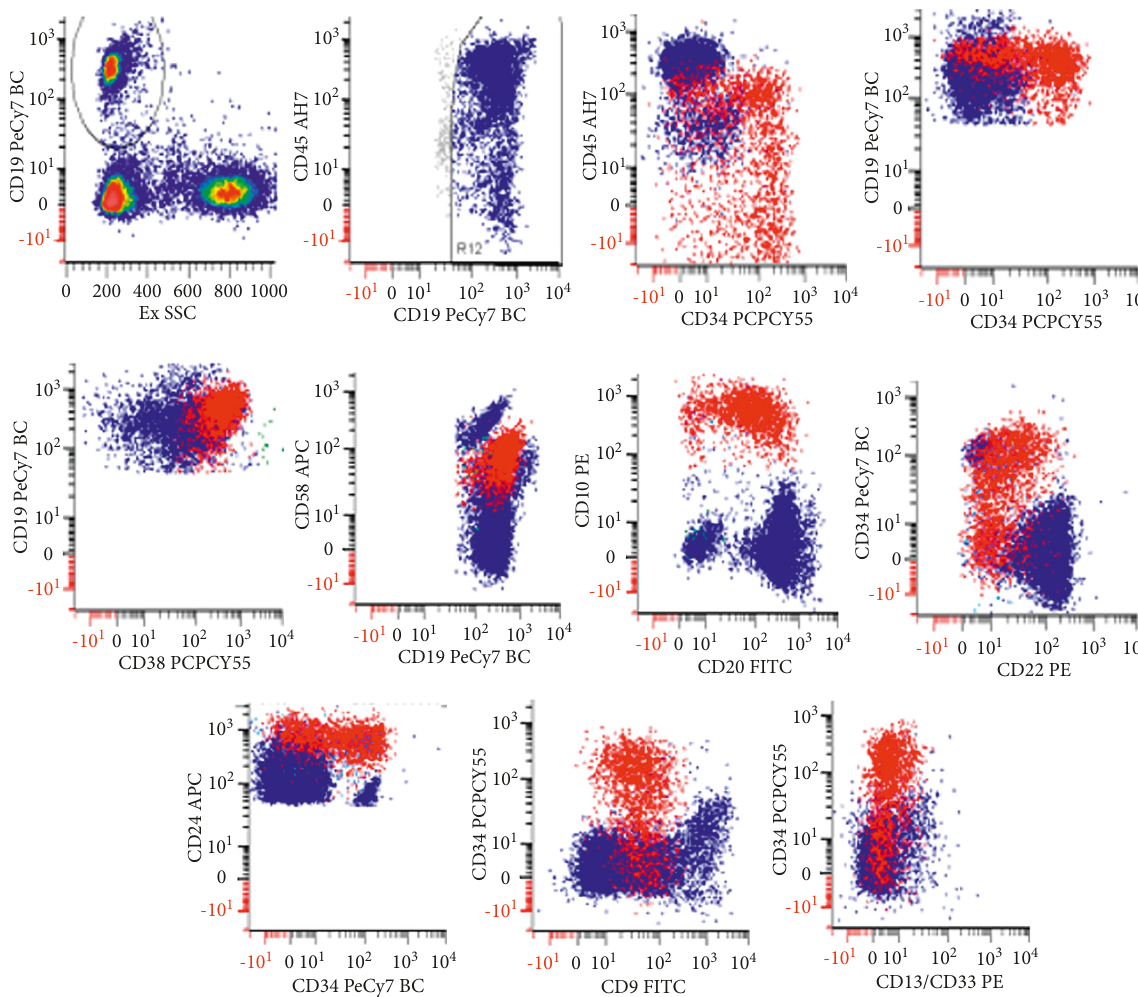
Figure 3: Flow cytometric immunophenotyping of the immature population in the bone marrow. The blasts express CD45 (heterogenous), CD19, CD34 (heterogeneous), CD38 (moderate), CD58 (bright), CD20, CD10, CD22 (dim), CD24 (heterogenous), CD9 (dim) and are negative for CD13 and CD33. B-lymphoblasts are red, mature B cells are blue.